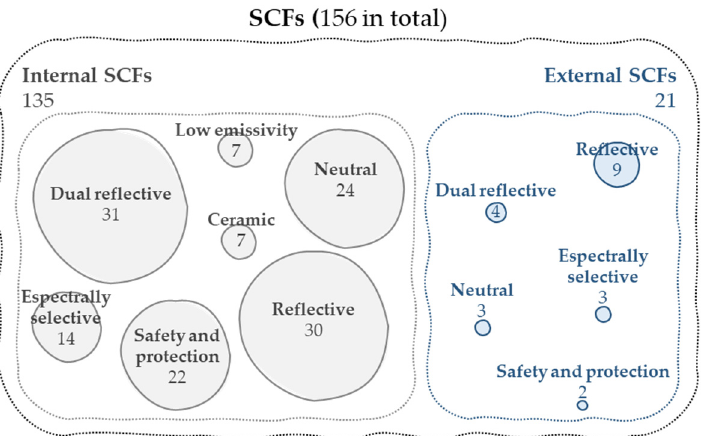
Figure 4. Quantity of each type of solar control film assembled after consulting version v72.0 of the IGDB database [31].